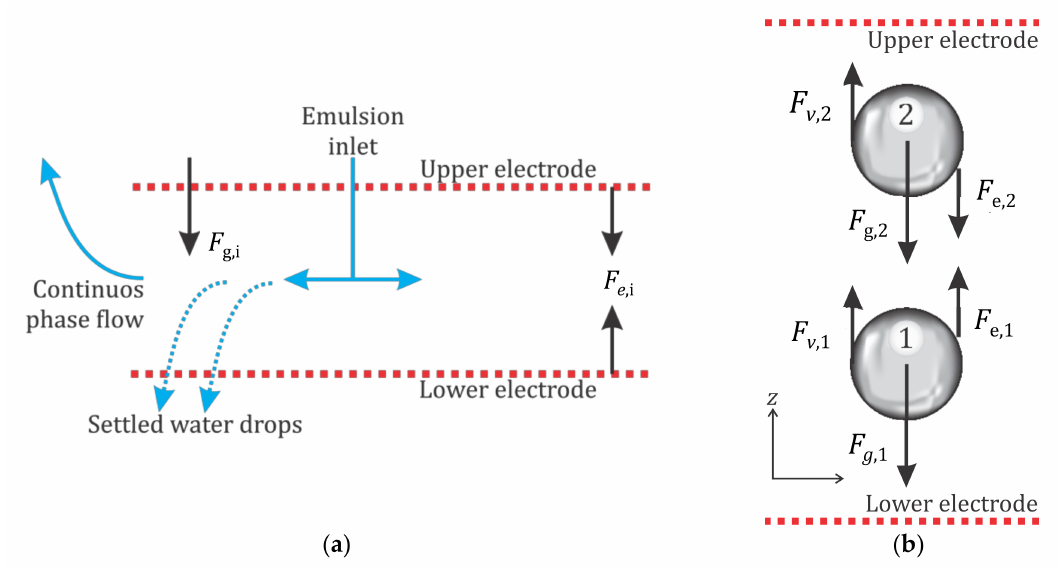
Figure 1. ( a ) Schematic representation of the desalting system, including the inlet of the emulsion, the electric field set up by the upper and lower electrodes and the flow of the continuous and droplets. ( b ) Schematic representation of all forces acting on two droplets of water, one on top of the other and both being in between the two electrodes. Forces include the electrostatic attraction ( F e ), drag ( F v ), gravity and buoyancy forces (indicated as F g